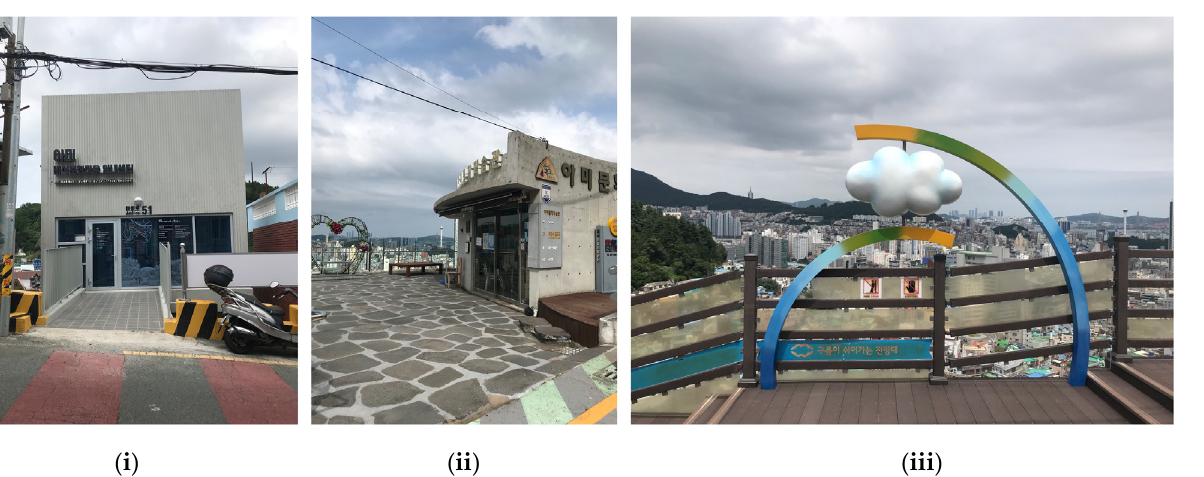
( iv ) Figure 10. Historic Trail: ( i ) Village Entrance, ( ii ) Photo Trail, ( iii ) Tombstone House, ( iv ) mini-ref- ugee museums.